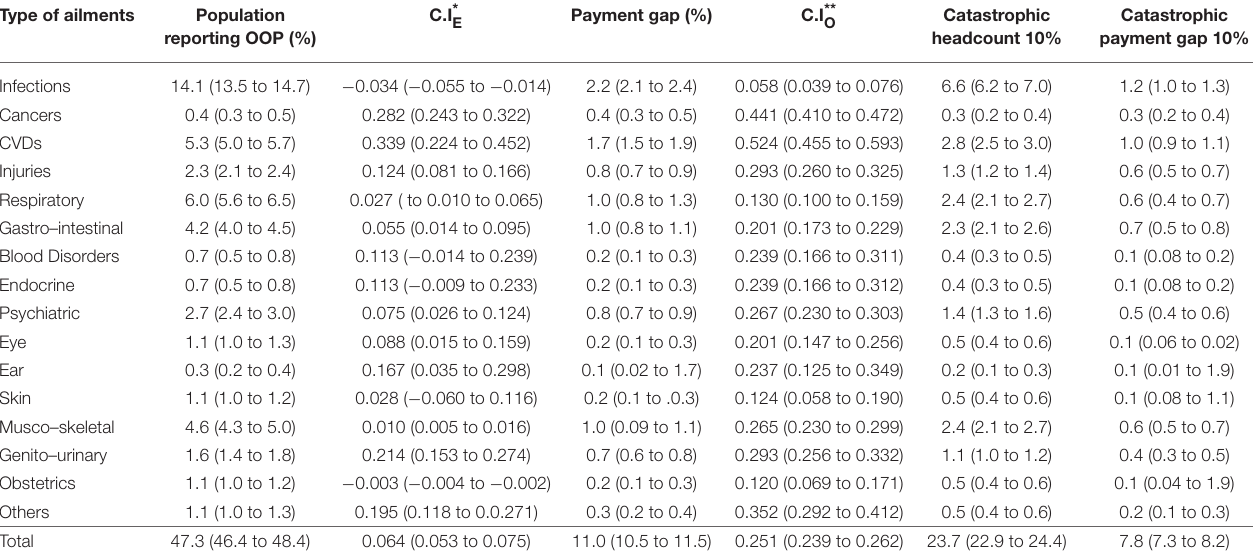
TABLE 1 | Economic burden of morbidity in India.